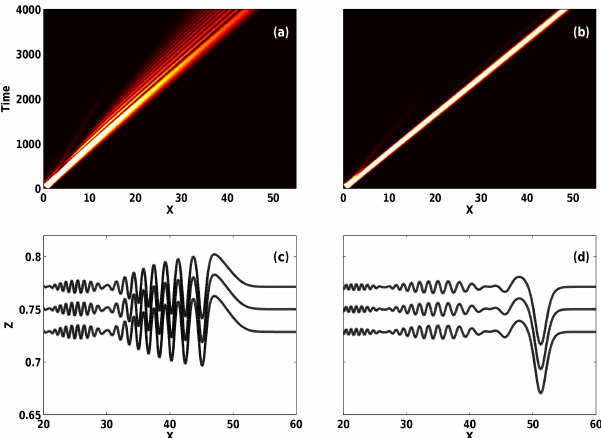
Figure 2. A space–time filled contour plot of vertically integrated kinetic energy and density isocontours at t = 4275 showing the dif- ferences between the positive and negative polarity initial condi- w 0 . Panels (a) and (c) correspond to the positive tions with w = 1 2 polarity case, and panels (b) and (d) to the negative